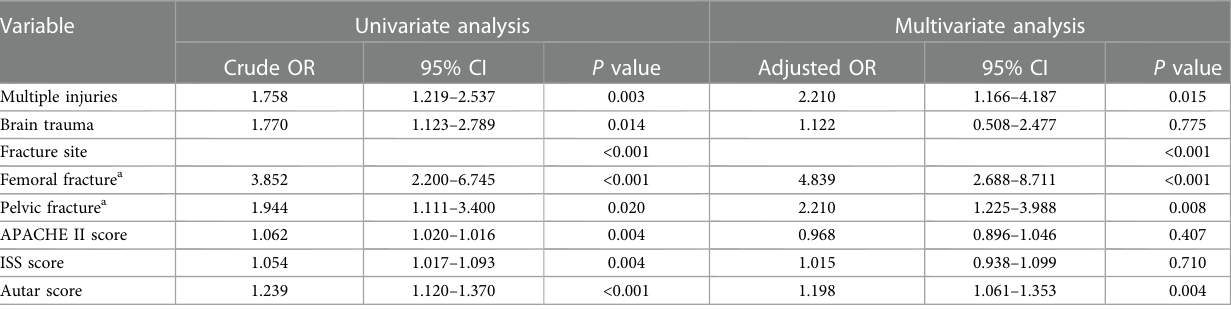
TABLE 2 Logistic regression analysis results of factors associated with DVT in patients with pelvic or lower-extremity fractures.